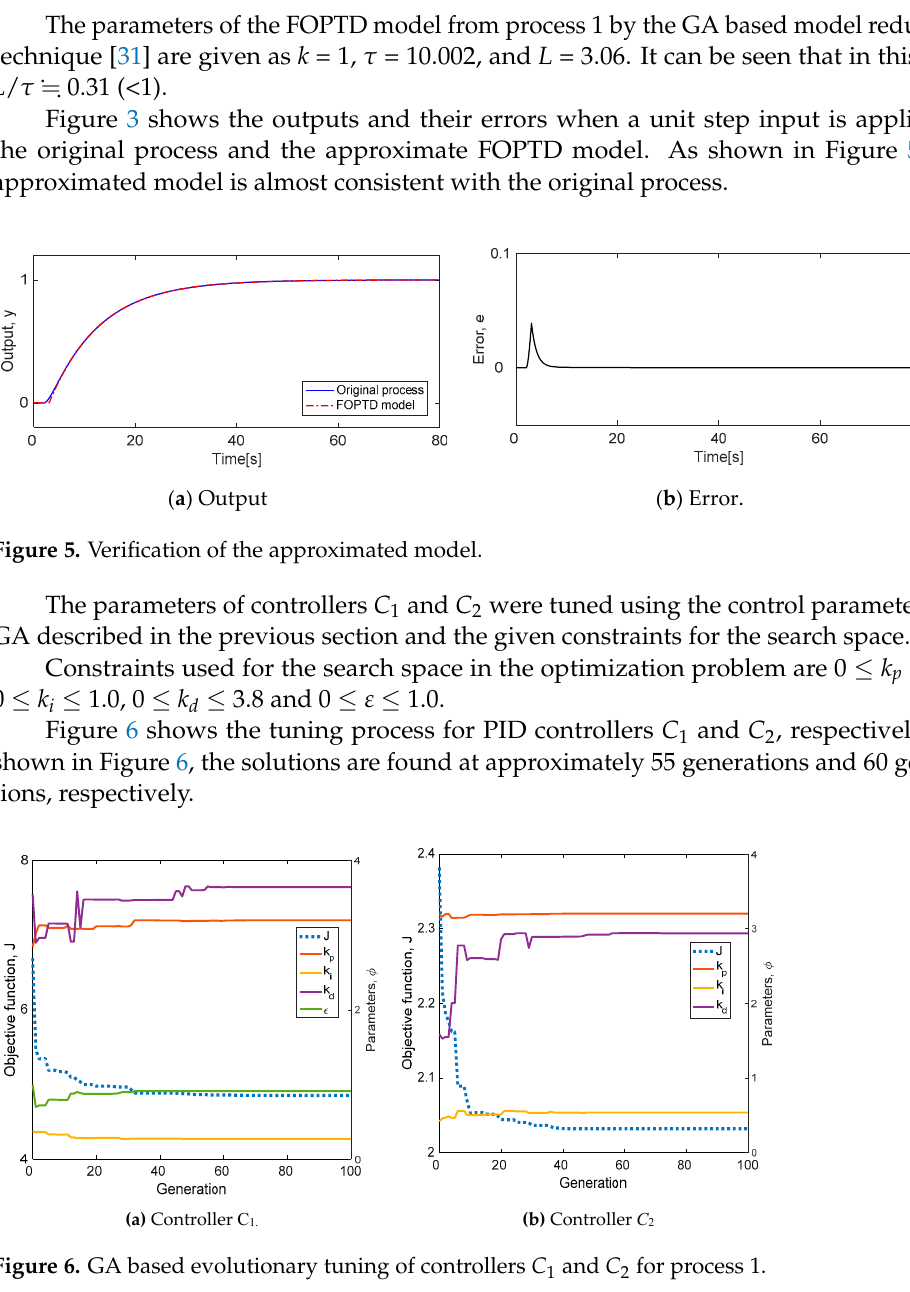
Table 1. PID controller tuning for process 1.